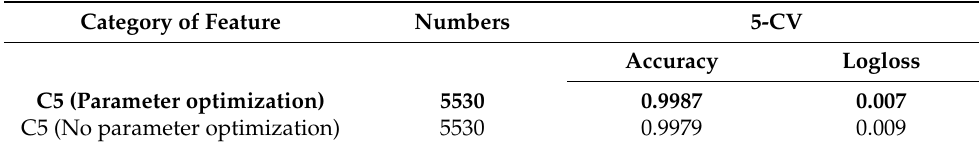
Table 7. XGBoost parameter optimization is used.